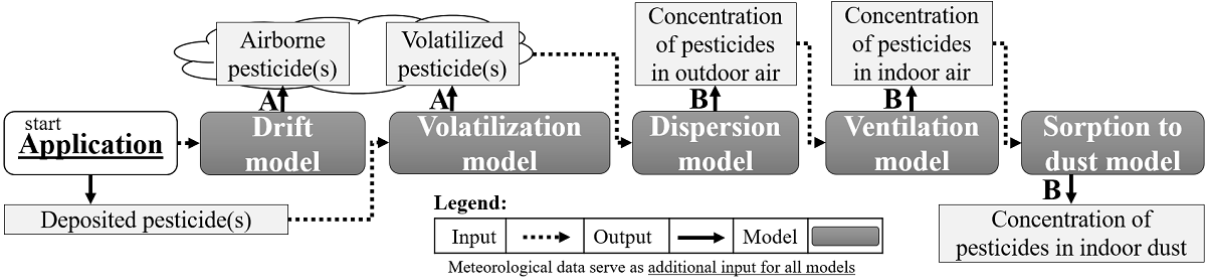
Figure 4. Deterministic modeling framework. (A) Models were calibrated with results from measurements and experimental studies. (B) Modeling steps were verified by comparing predicted and measured